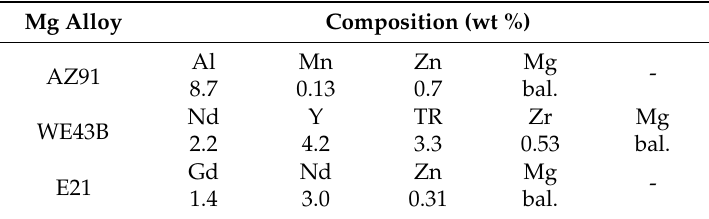
Table 1. Magnesium alloys tested.